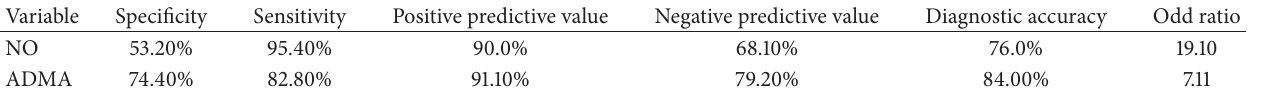
Table 5: Prognostic value of novel